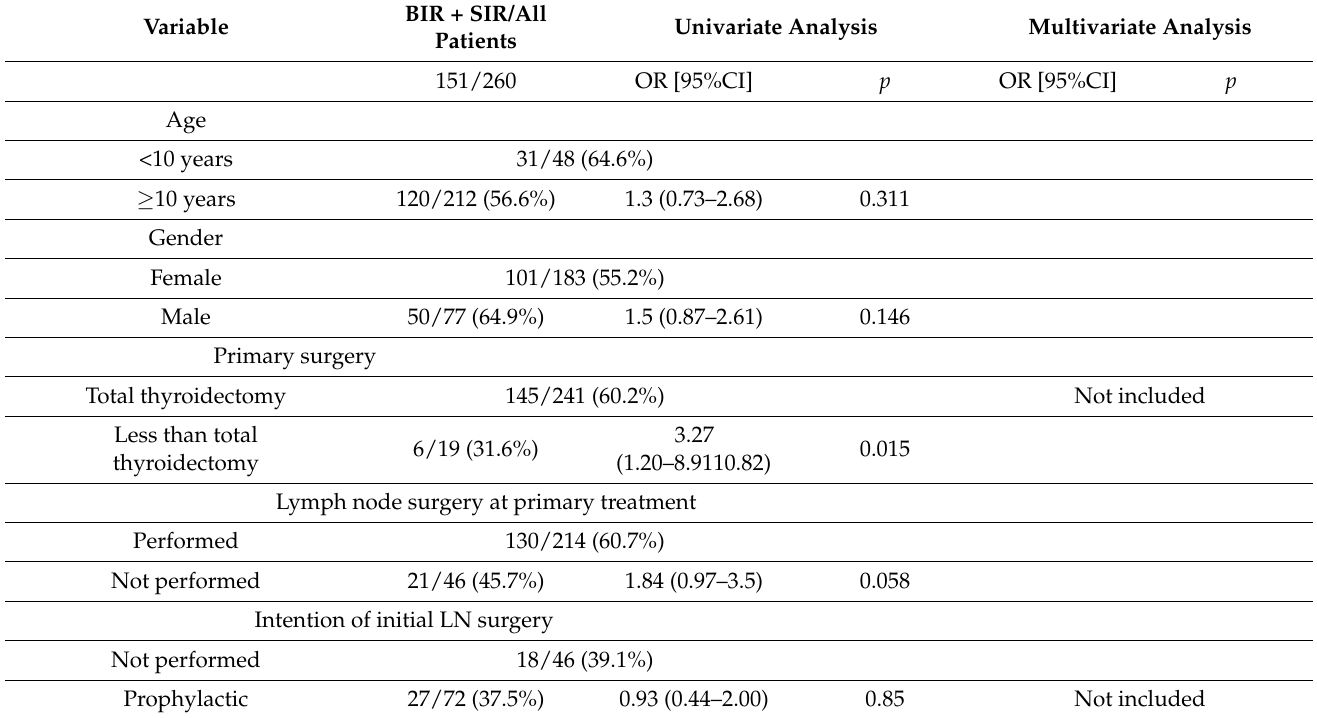
Table 4. Risk factors of persistent disease at 6–12 months after initial